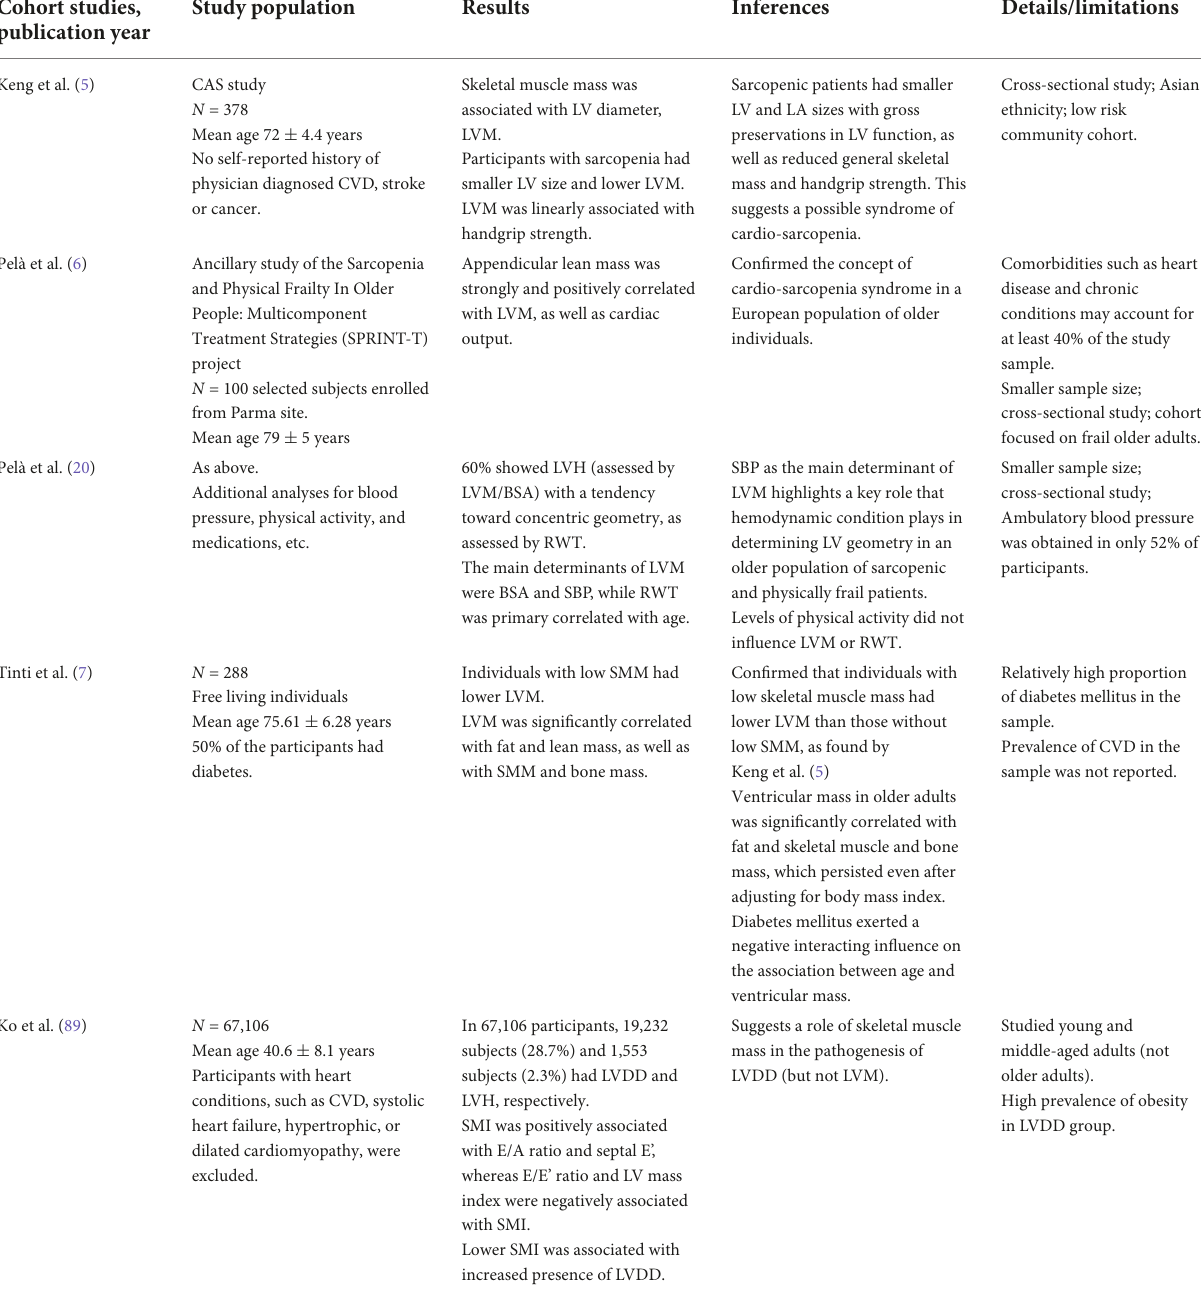
TABLE 1 Summary selection of community cohorts on skeletal muscle and cardiac